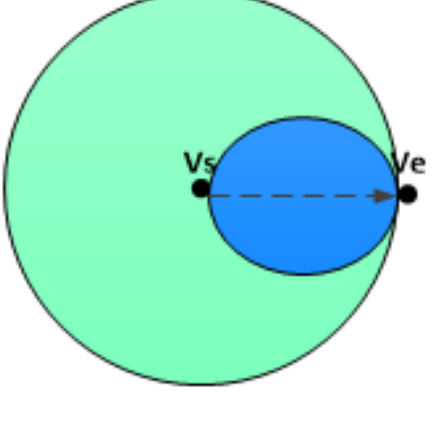
Figure 3. Search space of the A*